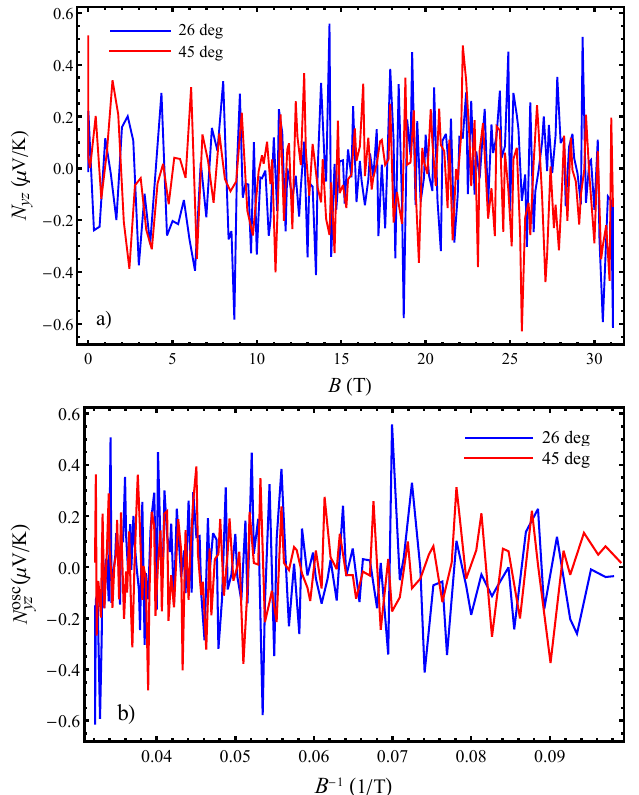
Figure 7. ( a ) Magnetic field dependence of the total Nernst effect in α - ( BEDT-TTF ) 2 KHg ( SCN ) 4 obtained at T = 0.6 K and different angles: θ = 26 ◦ ,45 ◦ that correspond to the first maximum and first minimum in the Hall resistance angular oscillations, respectively. ( b ) Magnetic quantum oscillations of the Nernst effect with the inverse magnetic field at the same angles ( B is in the range 10–30 T). The quantum oscillations display a complex structure with multiple periodicities. With tilting the field at the first AHRO minimum ( θ min1 = 45 ◦ ), the oscillatory features become more prominent, but the Nernst effect is in general small. An important observation is that when the field is located at the AHRO minimum, the Nernst effect changes sign first at a low field, then in between 10 and 18 T, and again just before entering the high-field CDW x state where it becomes negative. Above the kink field for this angle, B K = 25 T, the Nernst signal is weakly field dependent, resembling the behaviour of the Seebeck effect but with a smaller amplitude. Here, the field dependence changes from linear to non-linear at B min ∼ 3.5 T. The sign change in the field range B = 10–18 T is due to the formation of new electron and hole-closed orbits as a result of the magnetic breakdown.